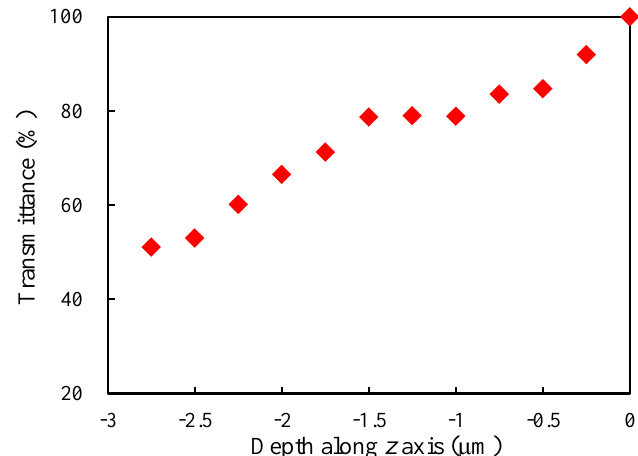
Figure 5. Evolution of the transmittance of the sample RVE with the depth along z